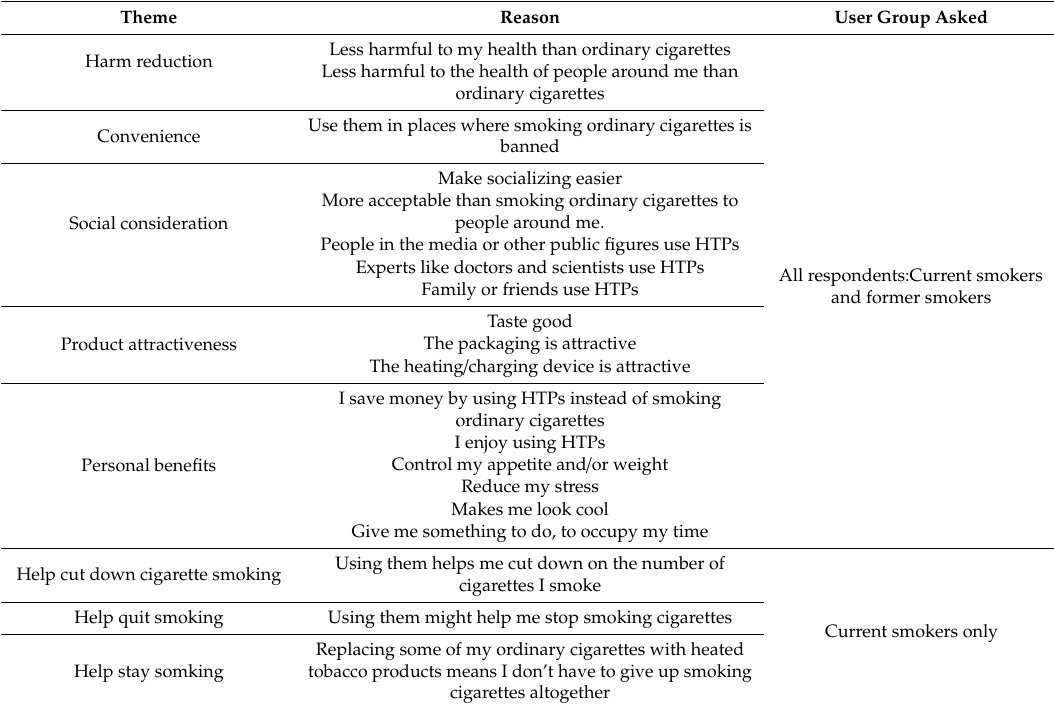
Table 1. Reasons for using heated tobacco products (HTPs) among current and former